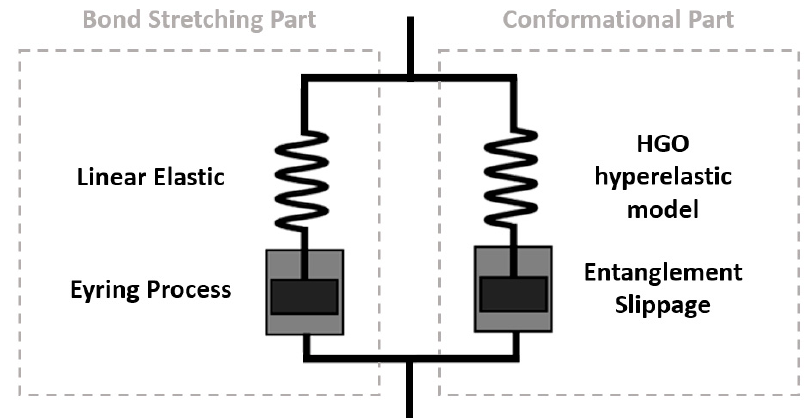
Figure 4. Spring and dashpot assembly of the proposed Buckley material model including modifications to the conformational part.